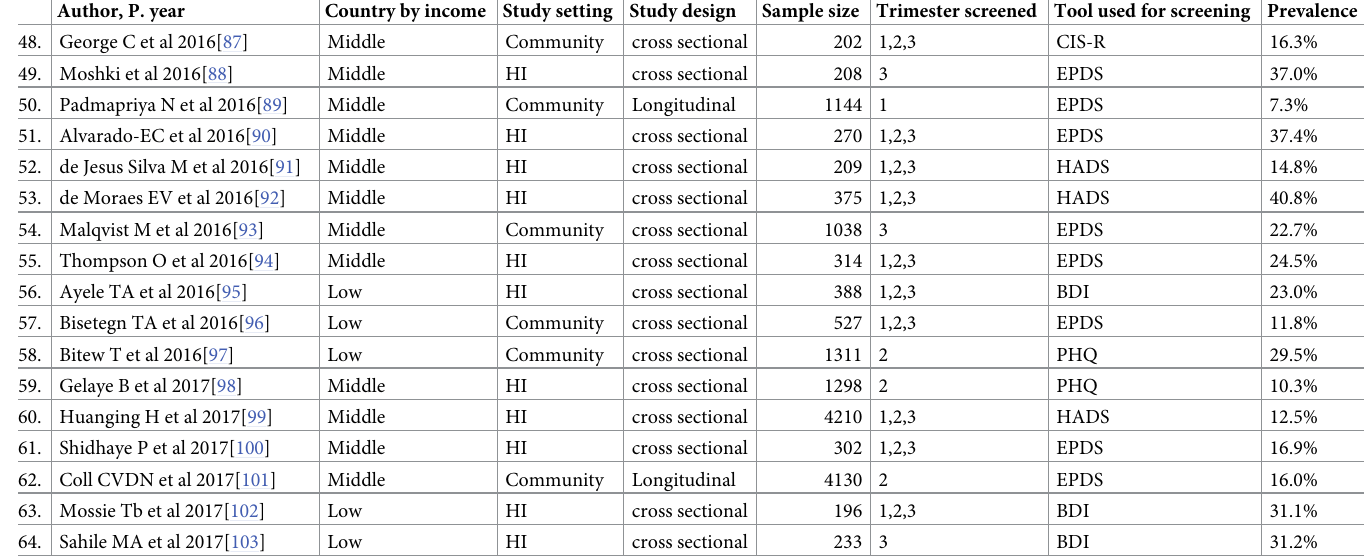
setting, sample size, tools used for screening, and time of pregnancy at which the screening has been conducted. As the Egger’s test for publication bias was significant (P < 0.001), Tweedie’s and Duval’s trim and fill analysis was used to report the final effect size under the random effect model. The pooled odds ratio was not affected when individual studies were omitted during the sensitivity analysis. (See in S1 File) High prevalence of antenatal depression was estimated in the year 2011–2012, (pooled prev- alence (PP), 95%CI: 28.6%; 22.3%-34.8%), followed by the year 2015–2016, (PP = 26.8%, 95% CI: 17.8%-35.8%). The antenatal depression was higher in low-income countries (PP = 34.1%, 95%CI: 22.7%-45.6%) and in health institution-based studies (PP = 27.6%, 95%CI: 23%- 32.3%) as compared to high-income countries and community-based studies, respectively. Antenatal depression increased over the three trimesters; 17.1% (95%CI: 7.7%-26.5%) in the first trimester, 27.1% (95%CI: 19.7%-34.6%) in the second trimester, and 28.9% (95%CI: 23.7%-34.1%) in the third trimester. The antenatal depression prevalence was estimated to be higher among the studies with sample less than 600 participants (PP = 25.7%; 95%CI: 22.1%- 29.5%) and those that used the Hopkins Symptom Checklist for screening depression (PP = 58.9%, 95%CI; 21%-96.8%). (Table 2) We have also summarized and pooled the effect size for reported risk factors under rela- tively homogeneous groups. Accordingly, bad obstetric history (Pooled Odds Ratio (POR) = 2.01; 95%CI: 1.67, 2.42) in 16 studies and economic difficulties in 14 studies (POR = 2.03; 95% CI: 1.63, 2.53) were significantly associated with increased risk of antenatal depression. Simi- larly, having poor social support (POR = 1.77; 95%CI: 1.49, 2.10) and history of common men- tal disorders (POR = 3.27; 95%CI: 2.47, 4.33) were increased the risk of antenatal depression in 13 studies. Moreover, having a history of violence in 11 studies (POR = 2.99; 95%CI: 2.20,